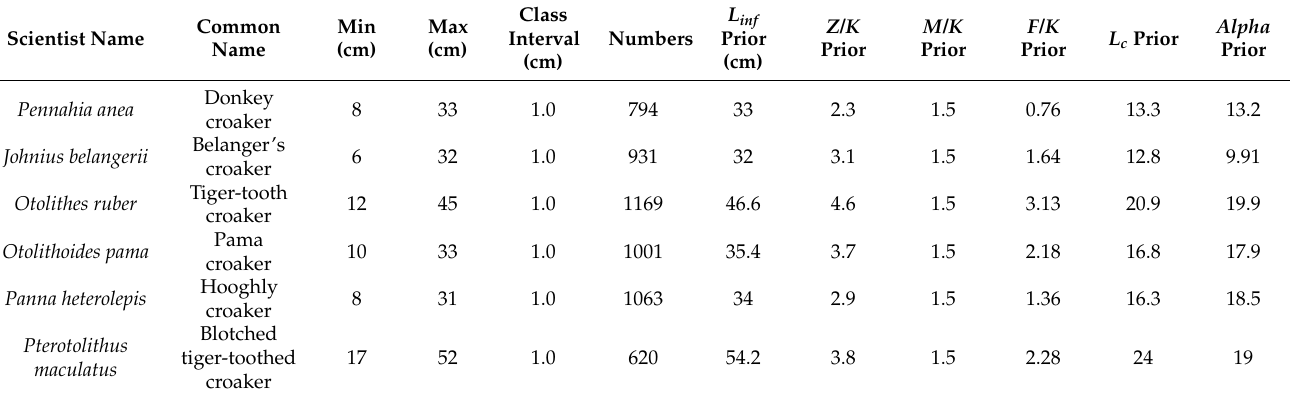
Table 1. Basic and prior information of six croaker species in BoB for the LBB approach.